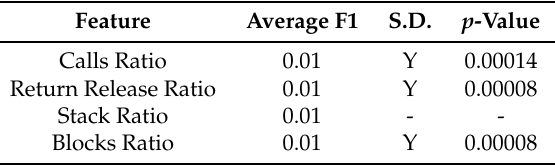
Table 18. ISFB Previous Numeric Feature